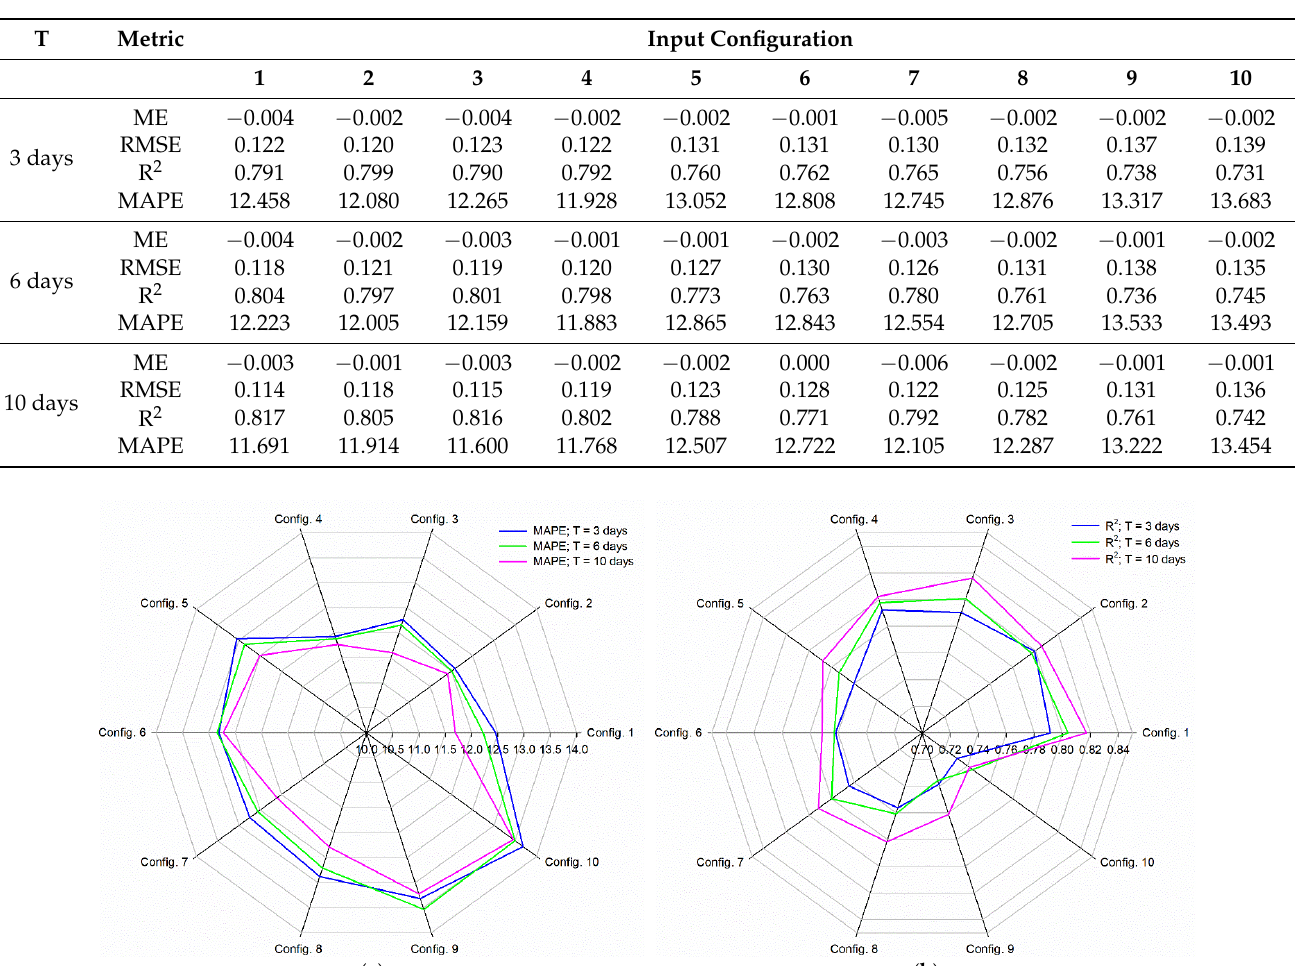
Table 7. RF model regression performance metrics.